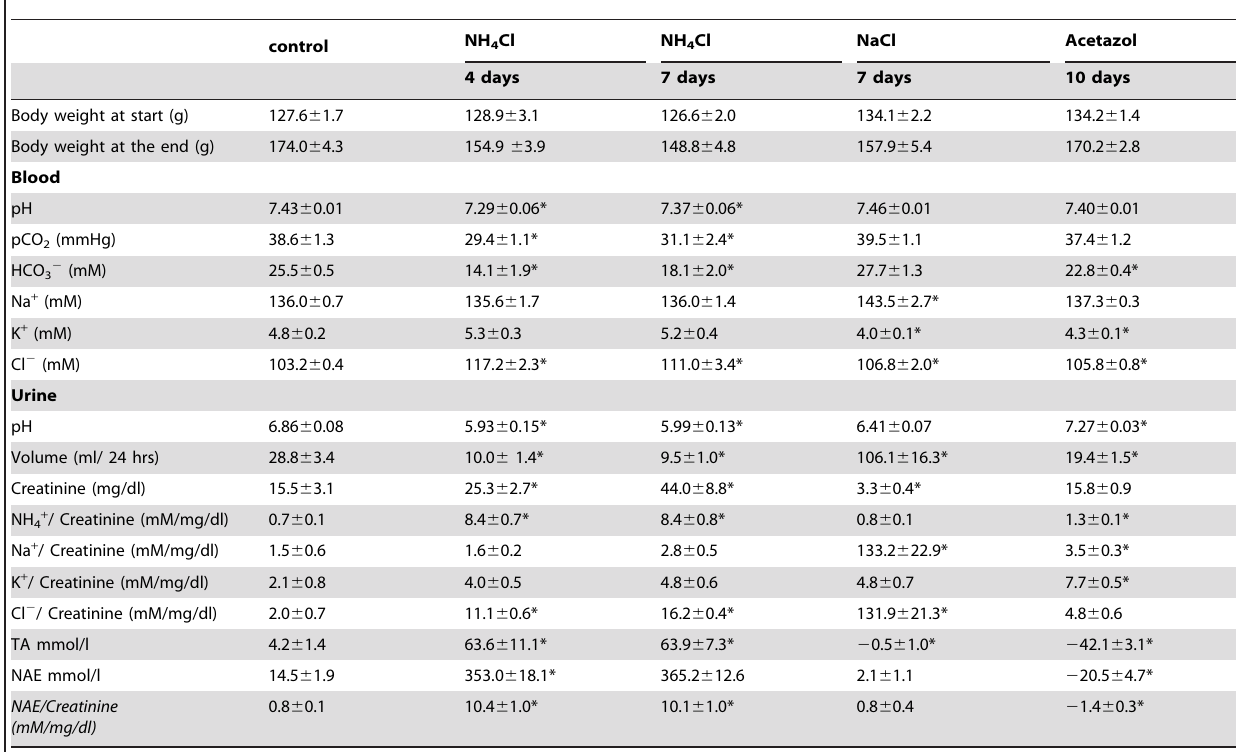
Figure 4. Remodelling and PCNA positive cell counts. ( A–C ) Summary of cells counts assessing the relative abundance of AE1, pendrin or AQP2 positive cells in the CNT, CCD, and OMCD of rats treated for 12 hrs, 4 or 7 days with NH 4 Cl in the drinking water. ( D–F ) Percentage of AE1, pendrin, or AQP2 positive cells that were also stained for PCNA under the different conditions. * marks significant difference compared to control. doi:10.1371/journal.pone.0025240.g004 Table 3. Arterial blood and urine data group 2